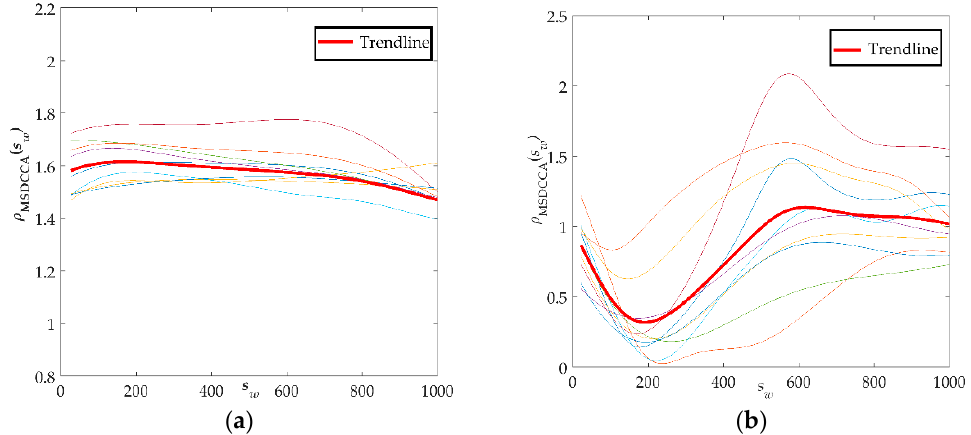
Figure 7. Result curve of ρ MSDCCA . ( a ) Analytical curves of ρ MSDCCA of all healthy controls with respect to the change of moving windows; ( b ) Analytical curves of ρ MSDCCA with the moving window in all hemiplegic patients.